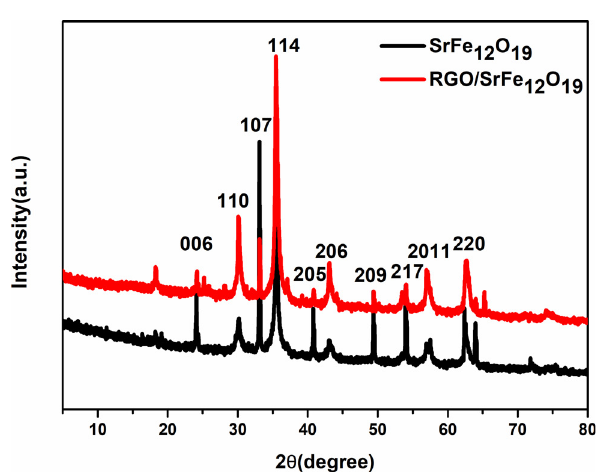
Figure 1: TEM images of (a) SrFe 12 O 19 nanoparticles and (b) RGO/SrFe 12 O 19